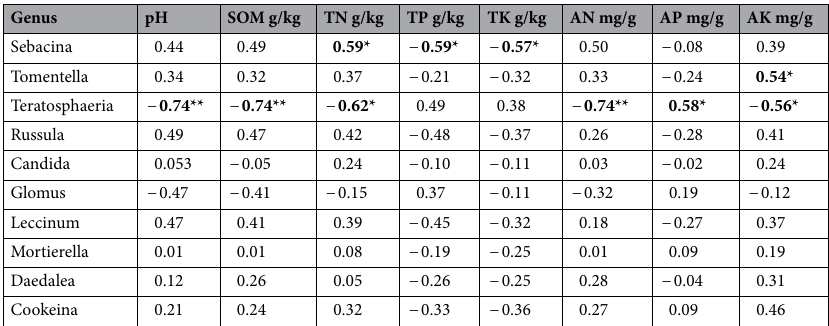
Table 4. Pearson Correlation analysis was used to determine the relationship of soil properties with soil fungi at genera level. * P < 0.05; ** P < 0.01; *** P < 0.0001. Soil organic matter (SOM), total and available nitrogen (TN and AN), total and available phosphorus (TP and AP), and total and available potassium (TK and